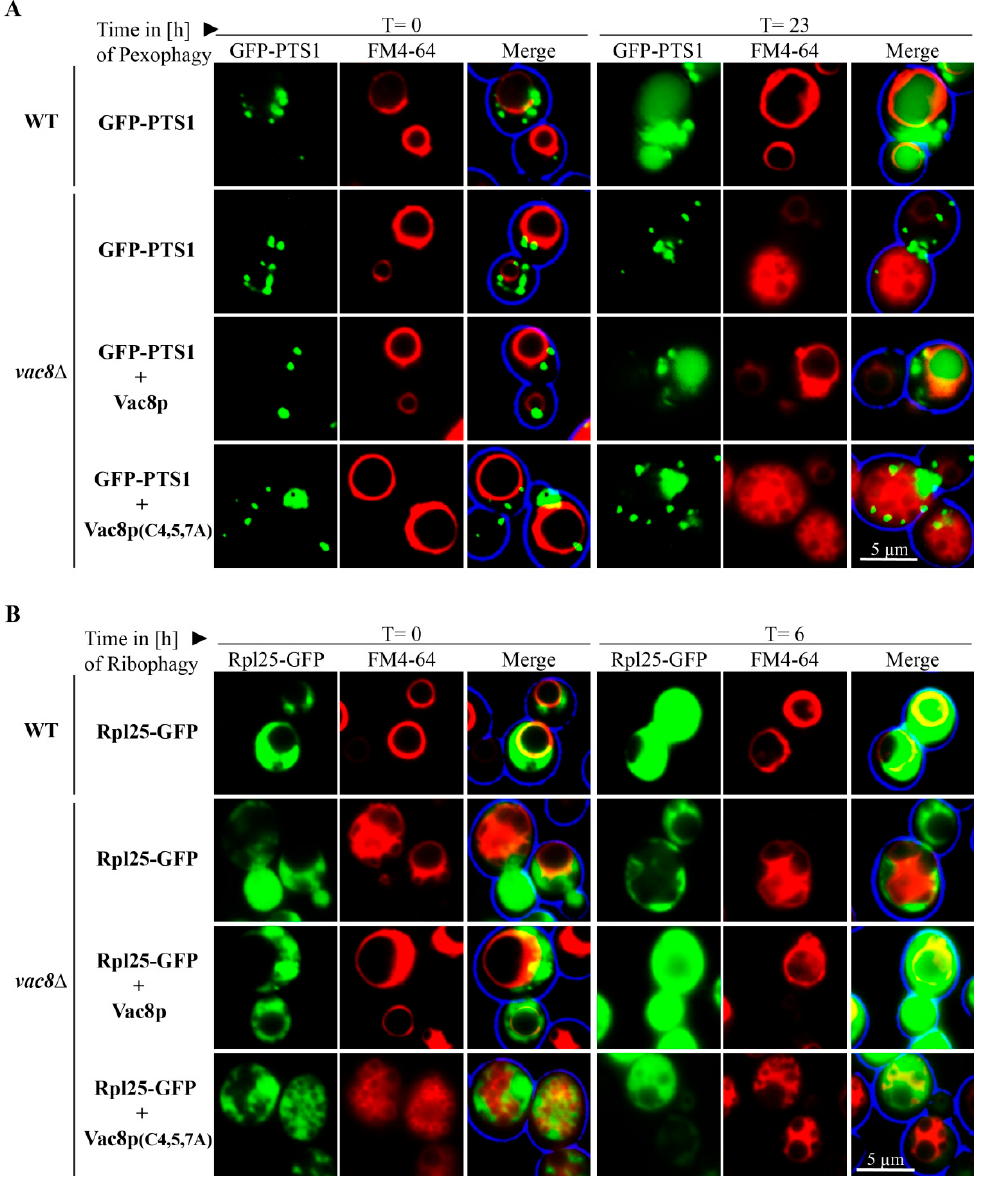
Figure 5. Palmitoylation of Vac8 is required for efficient pexophagy and ribophagy. ( A ) Peroxisomes were labeled with the matrix protein GFP-PTS1, while the vacuolar membrane was stained with FM4-64 for fluorescence microscopy. WT and vac8 Δ cells transformed with an integrating Vac8 plasmid are filled with a diffuse green staining at the end of the assay (t = 23 h), indicating peroxisomal breakdown. The vacuole does not display GFP signals in vac8 Δ cells without or with the palmitoylation-deficient Vac8(C4/5/7A), indicating a defect in pexophagy. ( B ) Ribosomes were marked with Rpl25-GFP, while the vacuolar membrane was labeled with FM4-64. At the end of the ribophagy assay (t = 6 h), the vacuoles of WT and vac8 Δ cells transformed with a Vac8 plasmid were filled with GFP signals, indicating ribosomal degradation. The vacuole does not display GFP signals in vac8 Δ cells and vac8 Δ cells transformed with the palmitoylation-deficient Vac8(C4/5/7A), strongly suggesting a defect in ribophagy.